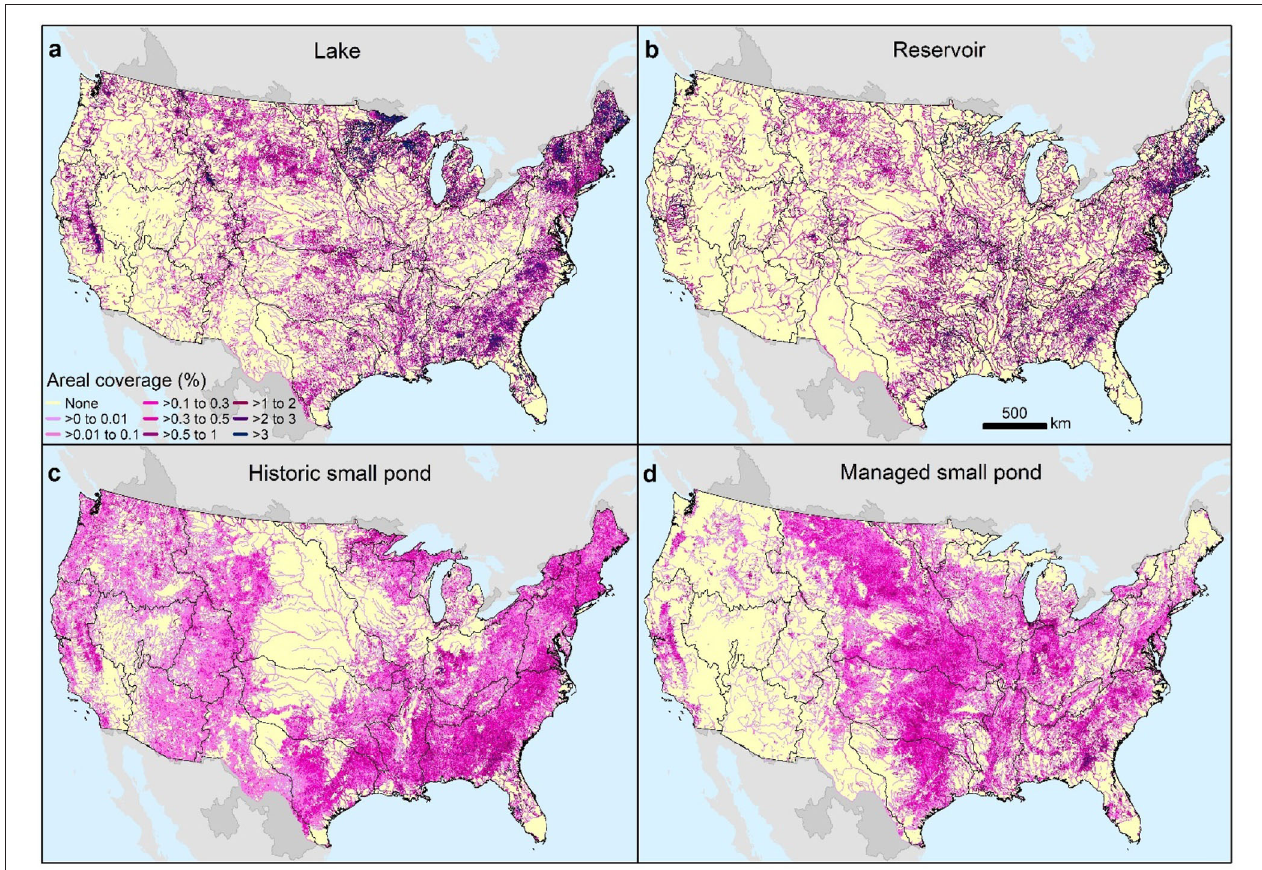
FIGURE 3 | Mapped distribution of surface water areal coverage for lakes (a) , reservoirs (b) , historic small ponds (c) , and managed small ponds (d) . The lentic percentage of total river corridor area varies little across the CONUS with reservoirs accounting for most of the lentic surface area (48%) followed by lakes (40%) and small ponds (12% total small ponds with 8% historic small ponds and 4% managed small ponds ( Table 1 ). Black boundaries designate the eighteen 2-digit hydrologic unit code (HUC-2) major river basins of the